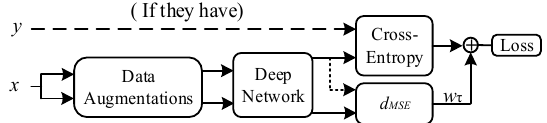
Figure 7. Pipeline of SSL based on consistency regularization.